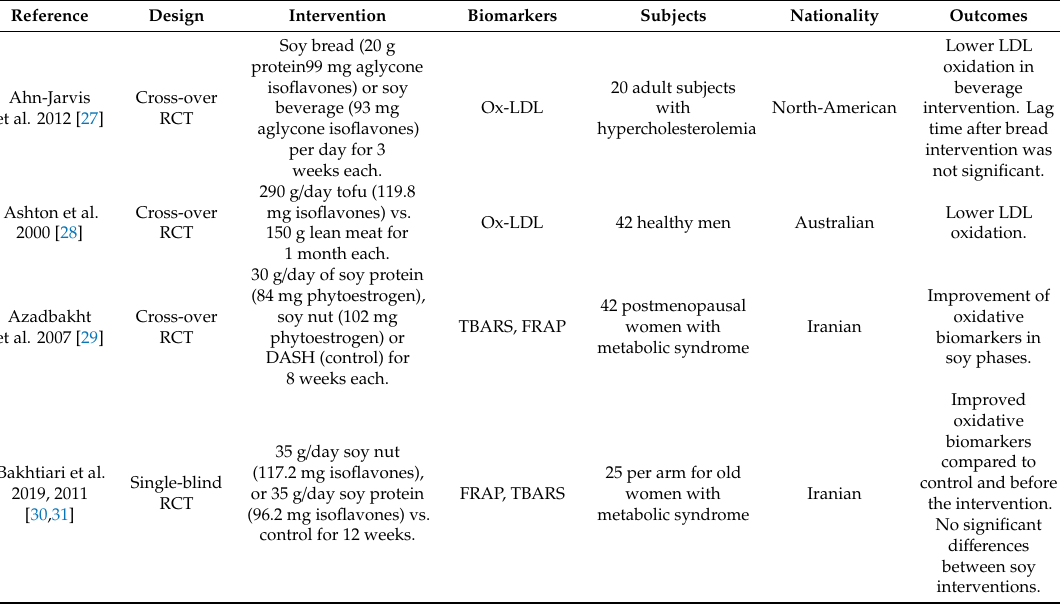
Table 1. Human clinical studies of the antioxidant e ff ect of